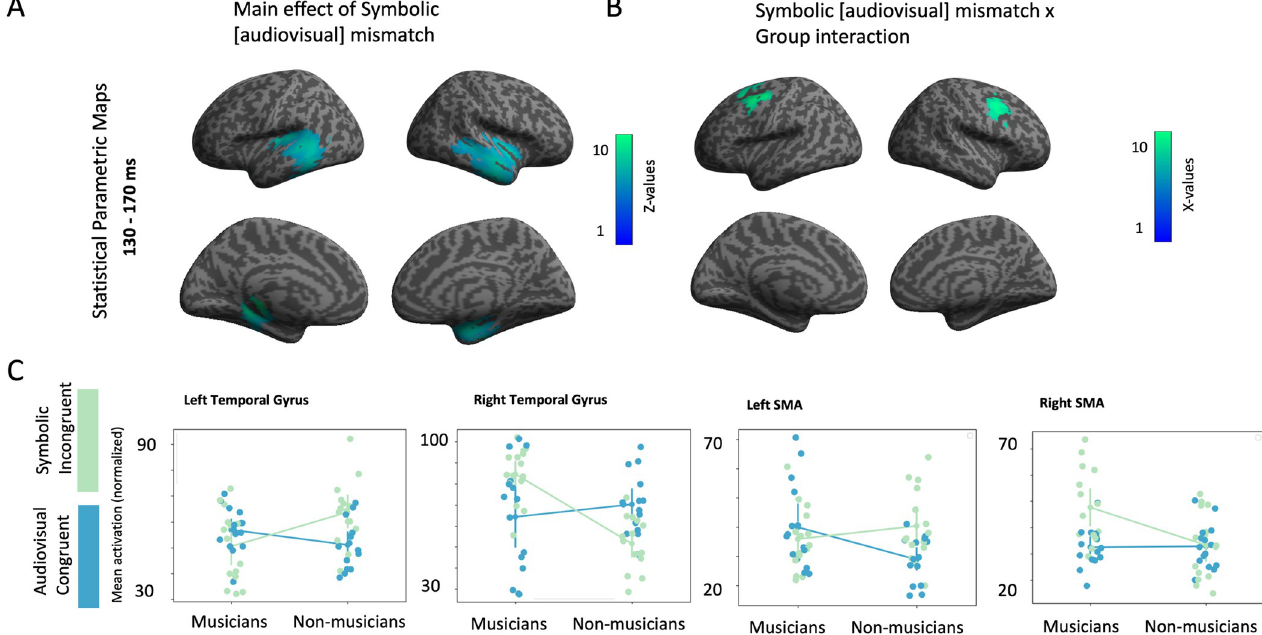
Fig 5. Audiovisual symbolic mismatch response generators in musicians and non-musicians. A: Statistical Parametric Maps for the main effect of audiovisual symbolic mismatch. Threshold p < 0.005, cluster corrected. B: Statistical Parametric Maps for the interaction audiovisual symbolic mismatch × group. Threshold p < 0.05, cluster corrected. C. Point plots depicting individual’s and mean activity for each statistically significant cluster of activation for the main effect of audiovisual symbolic mismatch and audiovisual symbolic mismatch × group interaction.